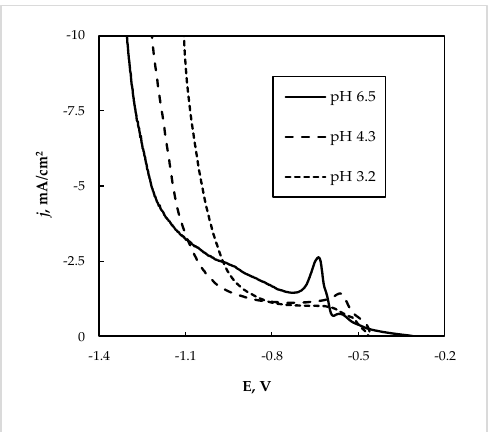
Figure 6. SEM image of Sn electrodeposit obtained at E = − 0.85 V and 60 °C from the solution “Ref”.